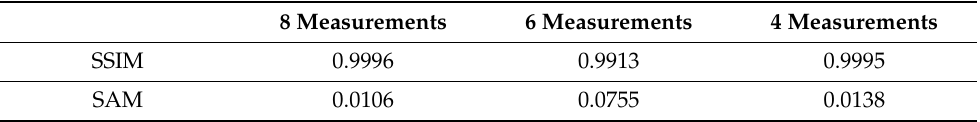
Figure 8. Figure shows 6 examples for comparison of spectra reconstruction from 3 SpLMs configurations: 8 measurements vs. 6 measurements vs. 4 measurements. The spectra have 224 bands in the range of (400 nm − 2500 nm ) . Table 1. The metrics of SSIM and SAM on the test set for configuration of 8 measurements, 6 measurements, and 4 measurements.